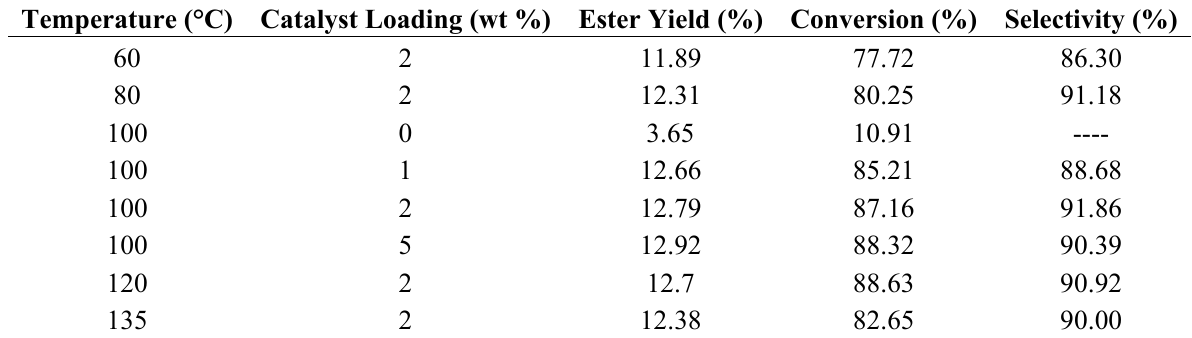
Table 2. Effect of single factor on ester yield and acid conversion (2